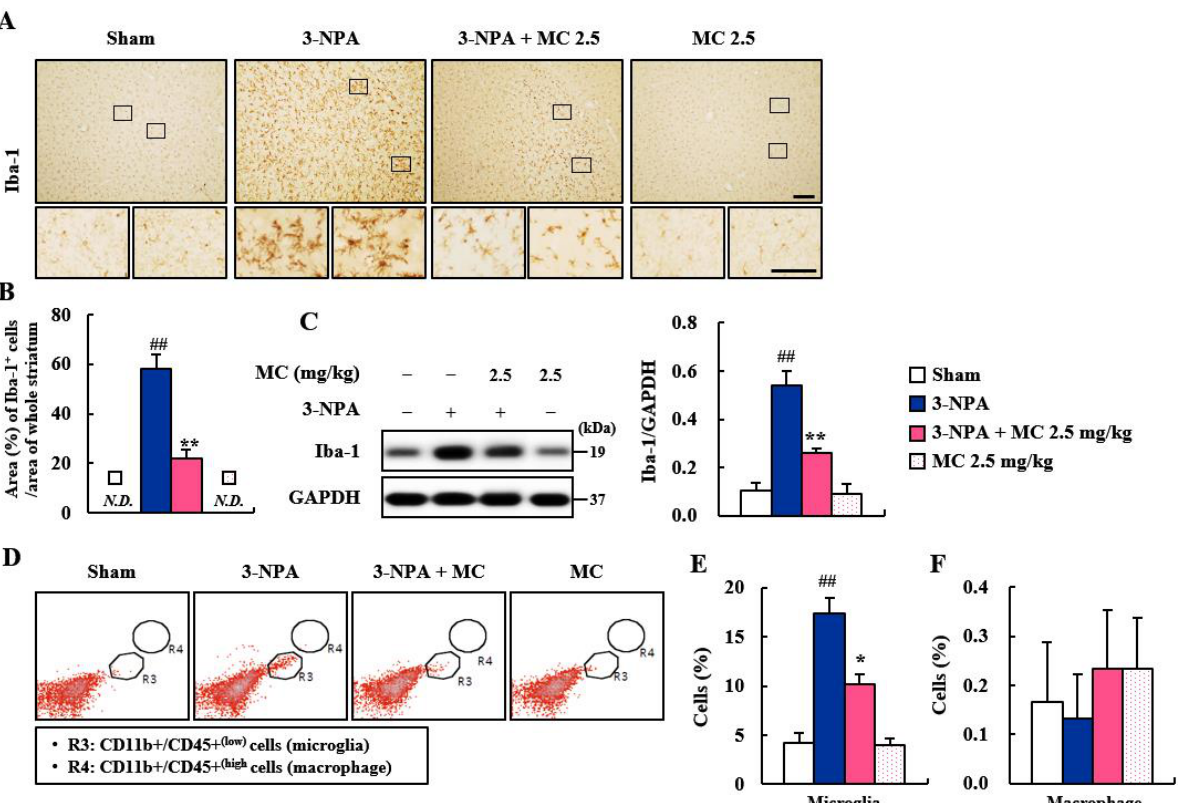
Figure 3. MC inhibits microglial migration and activation in striatum after 3-NPA treatment. ( A – F ) Twenty-four hours after the last (5th) 3-NPA treatment, striata from sham, 3-NPA, 3-NPA + MC (2.5 mg/kg/day), and MC (2.5 mg/kg/day) groups were used to investigate the levels of migration of microglia and infiltration of macrophages. MC prevented the migration and activation of Iba-1 (( C ): n = 5 group). MC reduced the level of migration of resident microglia (R3; CD11b + /CD45 +low ;